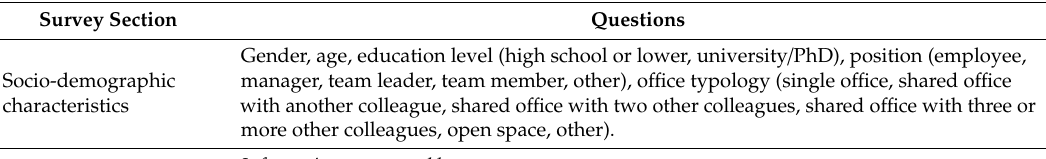
Table 1. Content of the